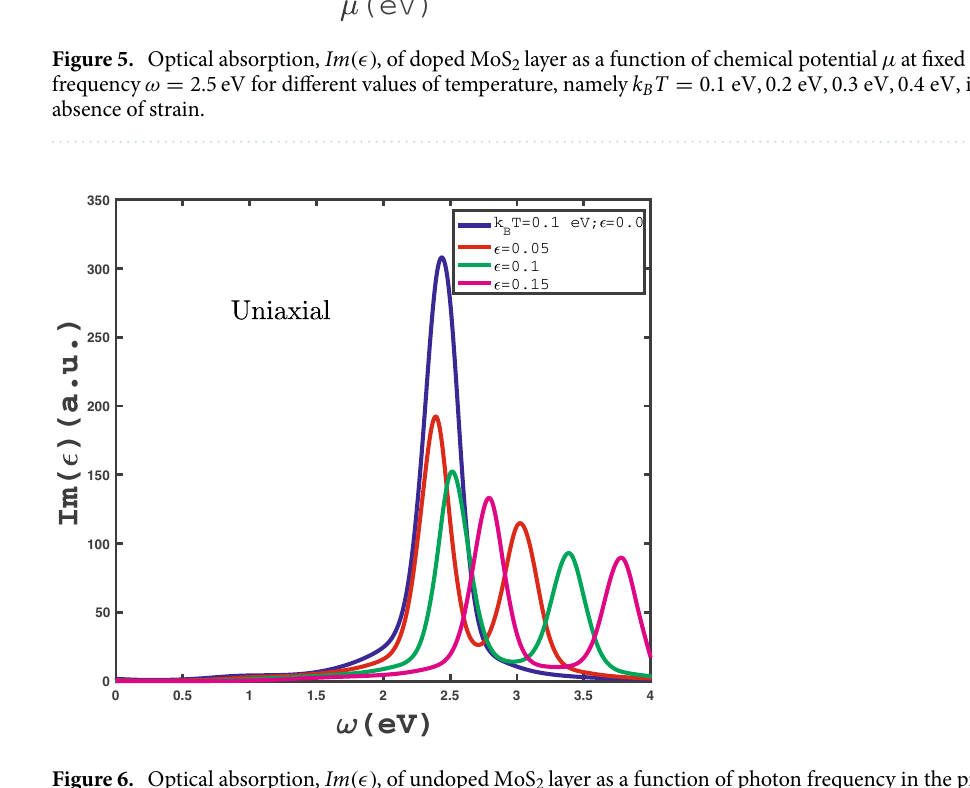
0.0, 0.05, 0.1, 0.15 , in the absence of = 0.1 =